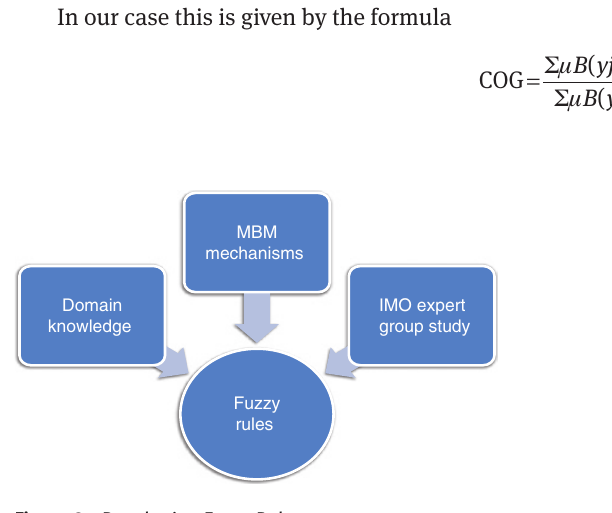
Figure 2: Developing Fuzzy